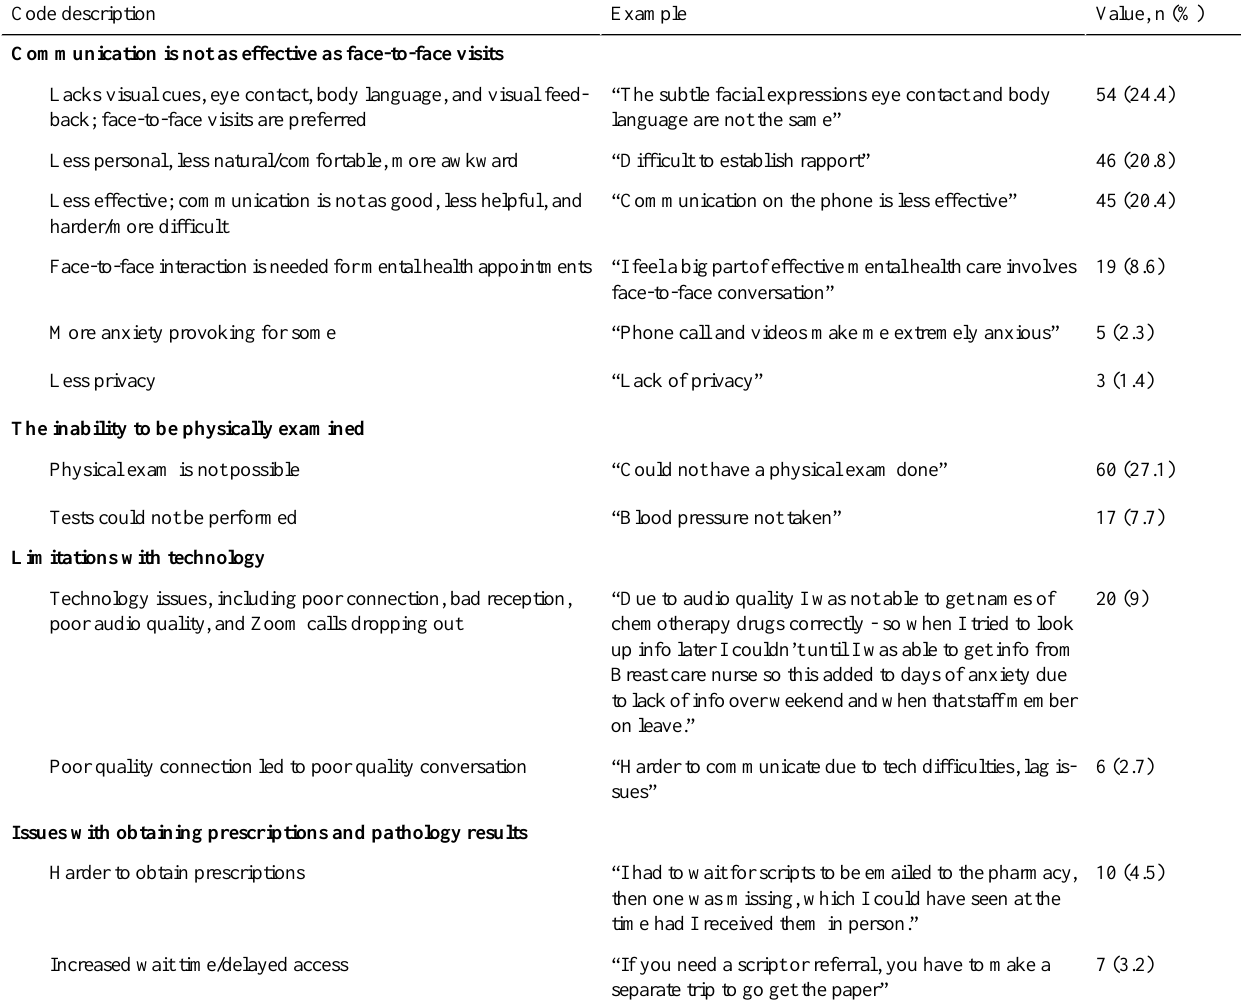
Table 4. Reasons provided by 221 respondents for telehealth visits being worse than traditional in-person medical visits, along with the frequency of overarching themes and subthemes with example quotes a